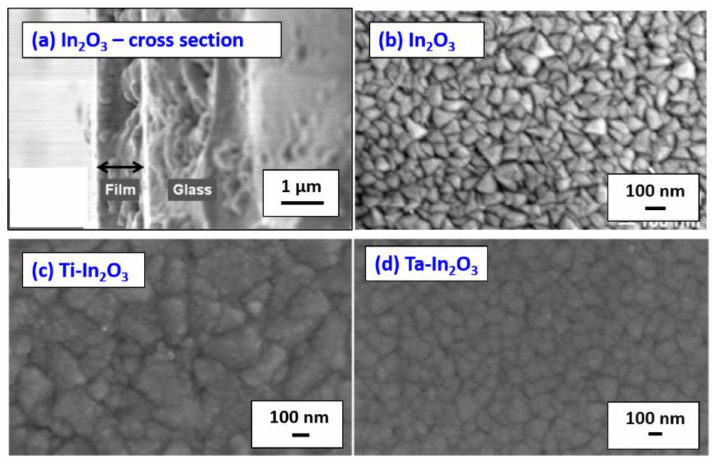
Figure 10. SEM images of ( a ) In 2 O 3 cross section, ( b ) In 2 O 3 , ( c ) Ti- In 2 O 3 and ( d ) Ta-In 2 O 3 . Reprinted from [95] with permission from American Chemical Society.